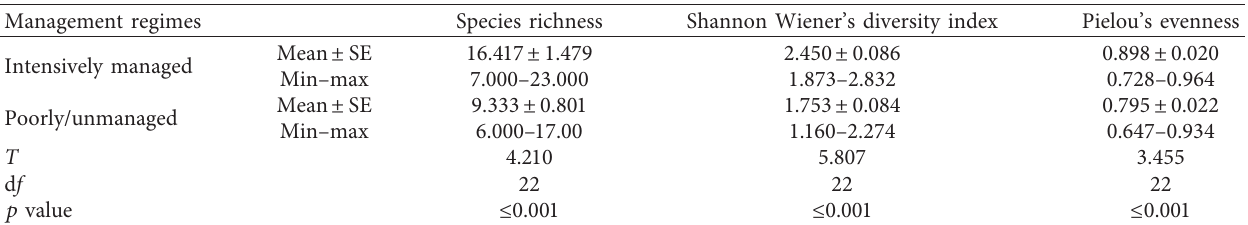
Table 4: Comparison of mean understorey species diversity, richness, and evenness in the intensively and poorly managed Tectona grandis